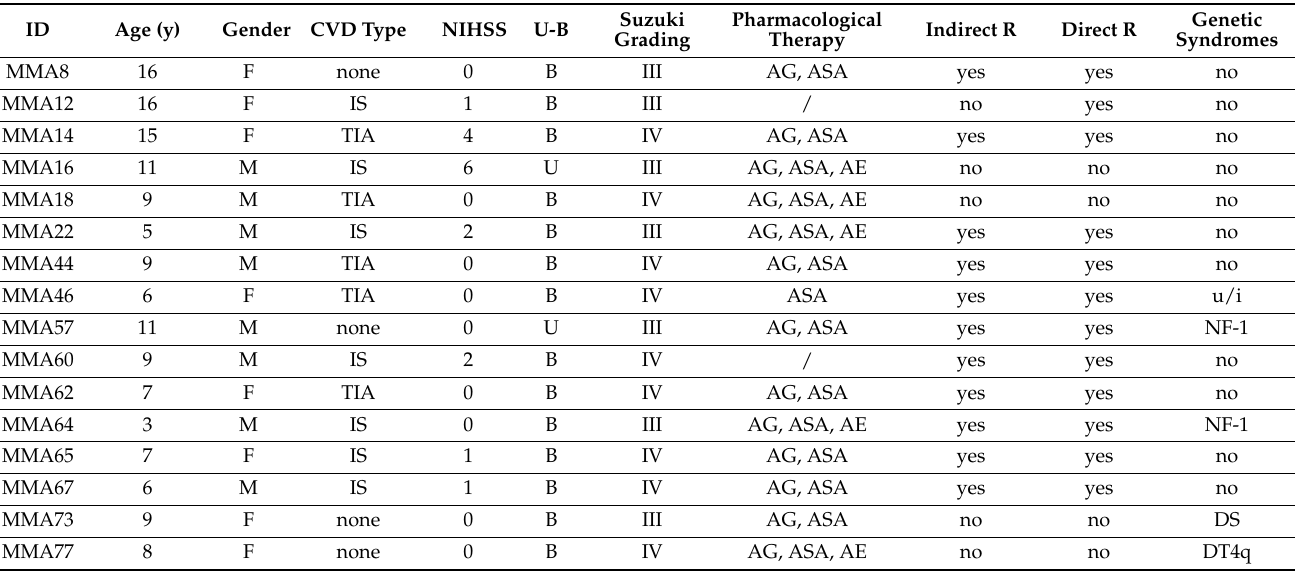
Table 1. Demographic, clinical, and neuroradiological features of MMA patients whose samples were included in biological